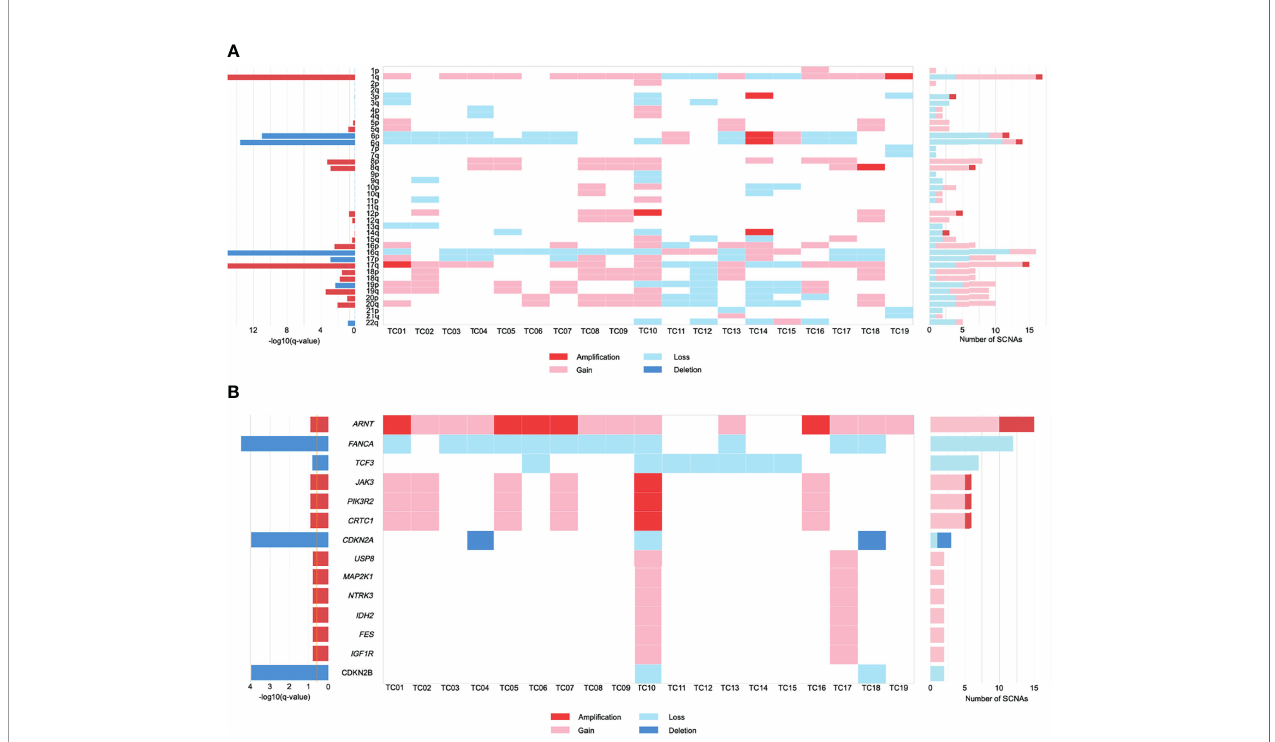
FIGURE 1 | The landscape of somatic copy number alterations (SCNAs) in thymic carcinomas. (A) Heat map of SCNAs at arm level (row) for each patient (column). Color is coded by SCNA type. The bar chart to the left depicts the statistical signi fi cance [-log10(q-value)] of each arm. The bar chart to the right depicts the number of total SCNAs. (B) Heat map of SCNAs at gene level (row) for each patient (column).